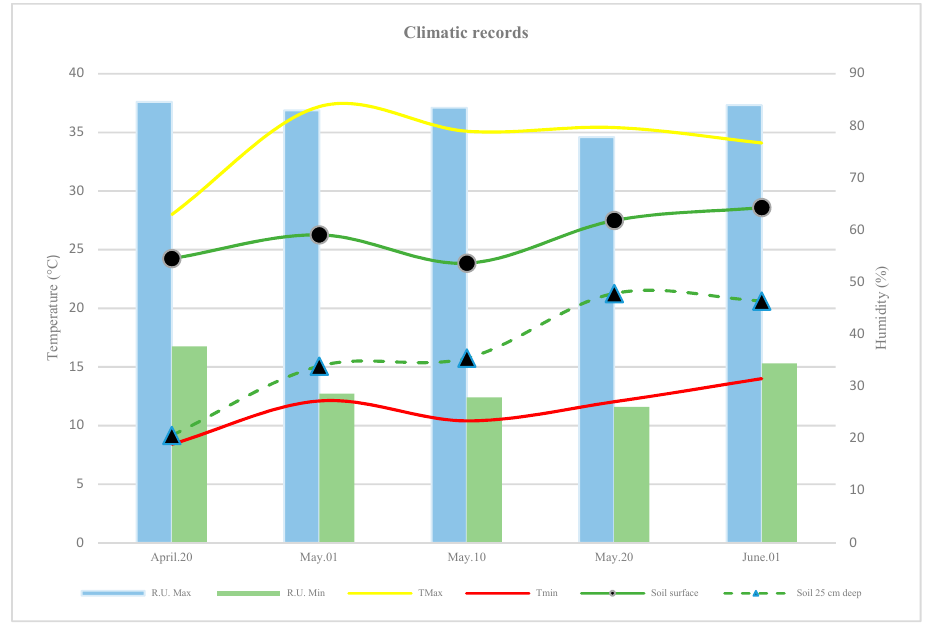
Figure 2. Records of air and soil temperatures (°C) and relative humidity (%) in greenhouse during the growing period. Table 1. Soil analysis of the experimental